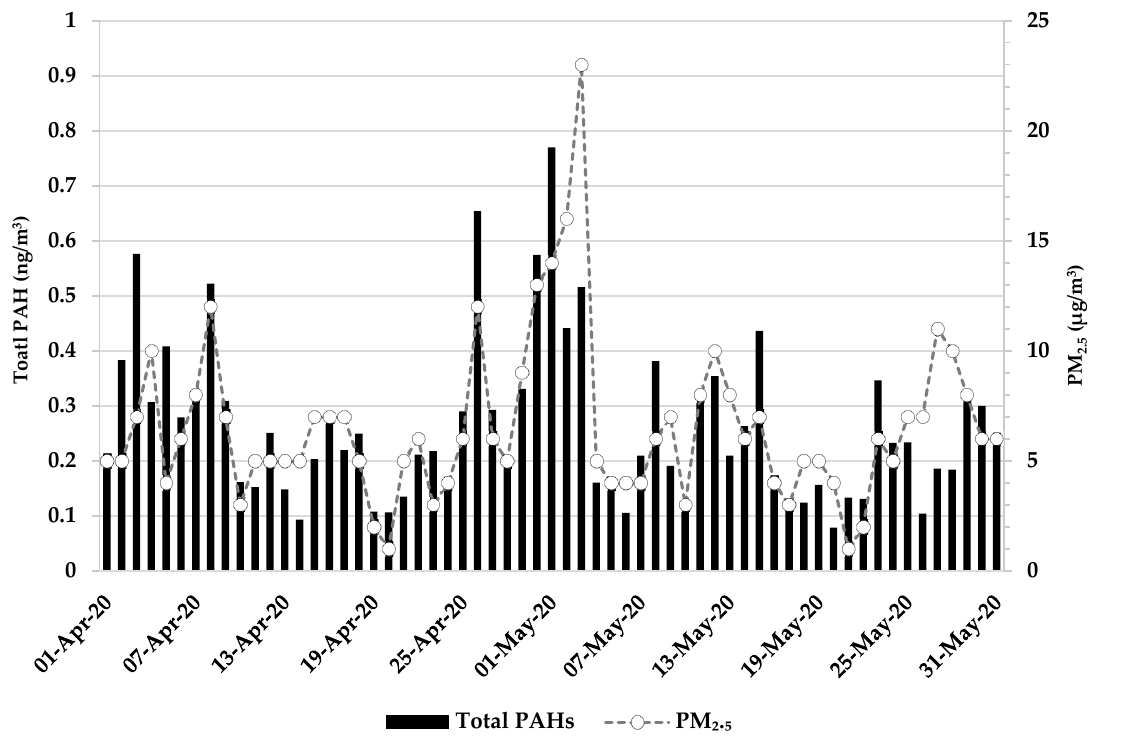
Figure 1. 24-h concentrations of pollutants. Table 2. Relationships between PAHs and nasal